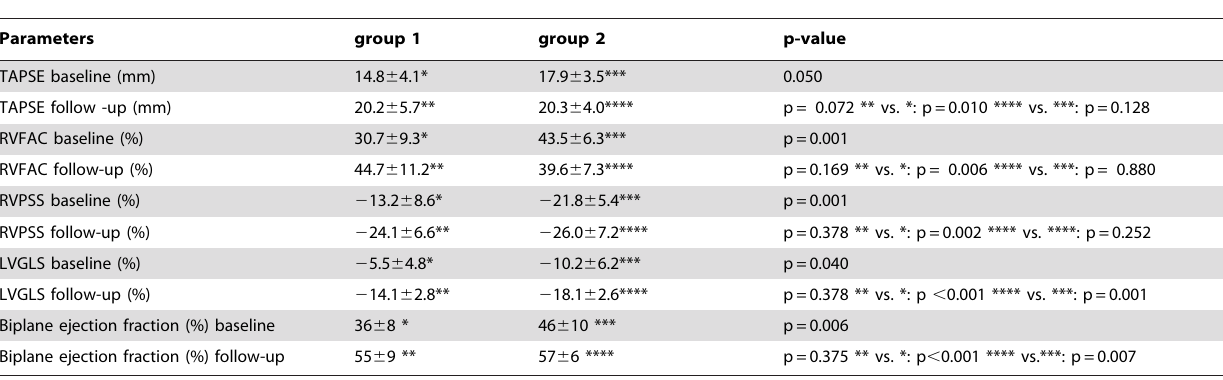
Table 3. Right and left ventricular echocardiographic parameters.